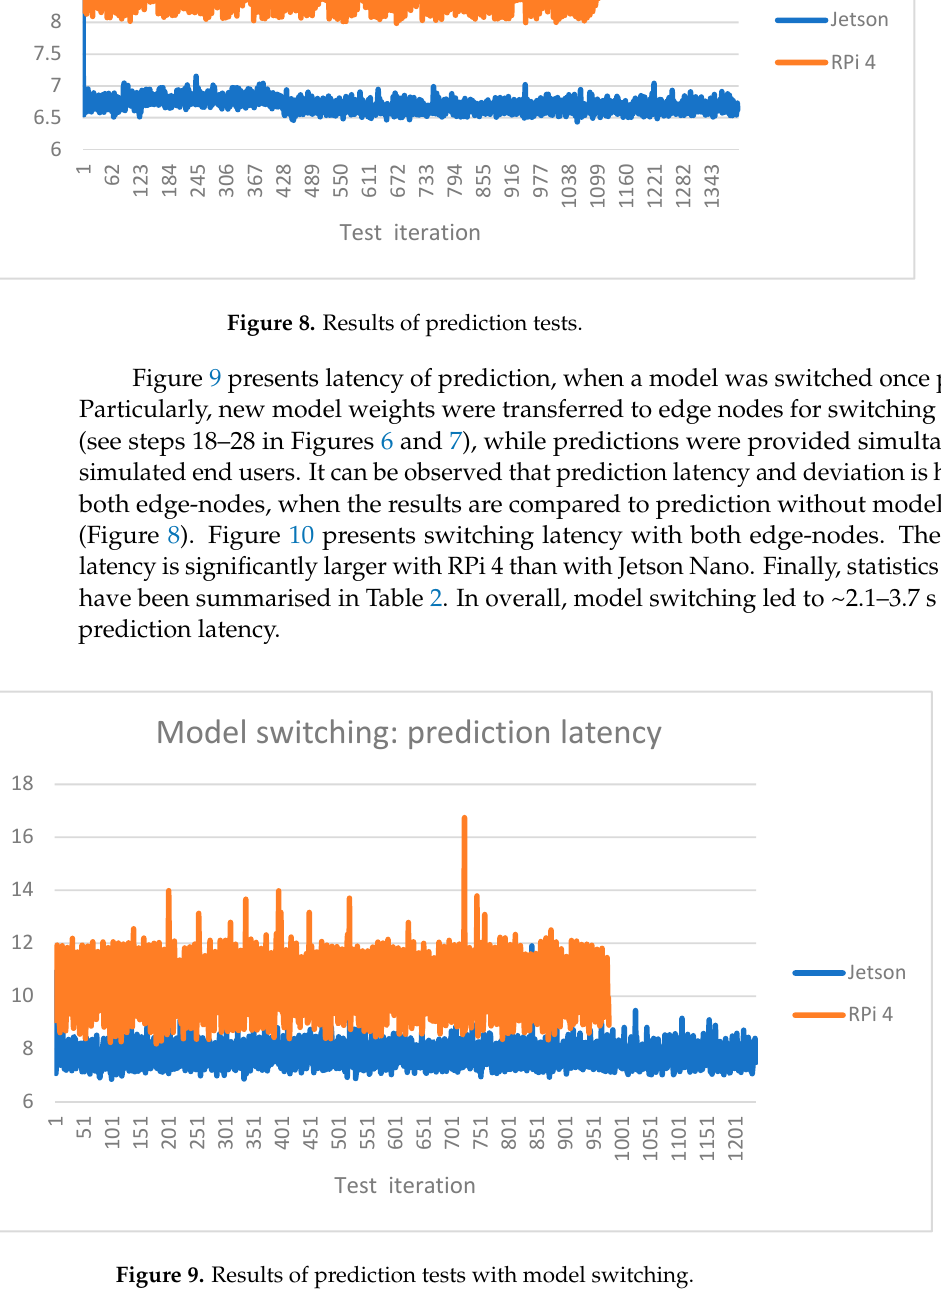
Figure 10. Results of model switching latency. Table 2. Latency in model switching tests. Inference